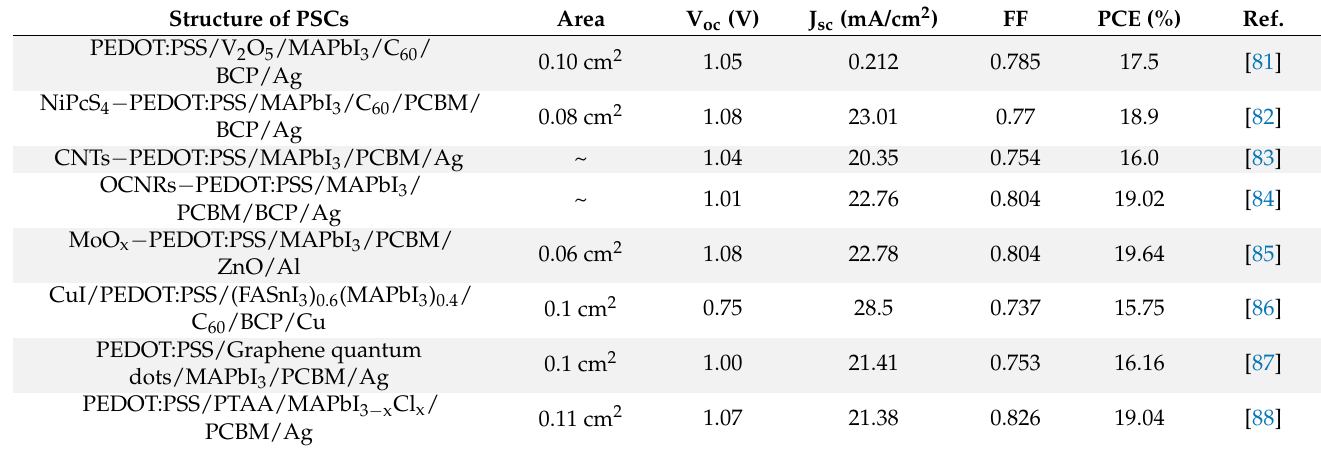
Table 5. Performances of several representative inverted PSCs on the basis of the composite HTL. Structure of PSCs